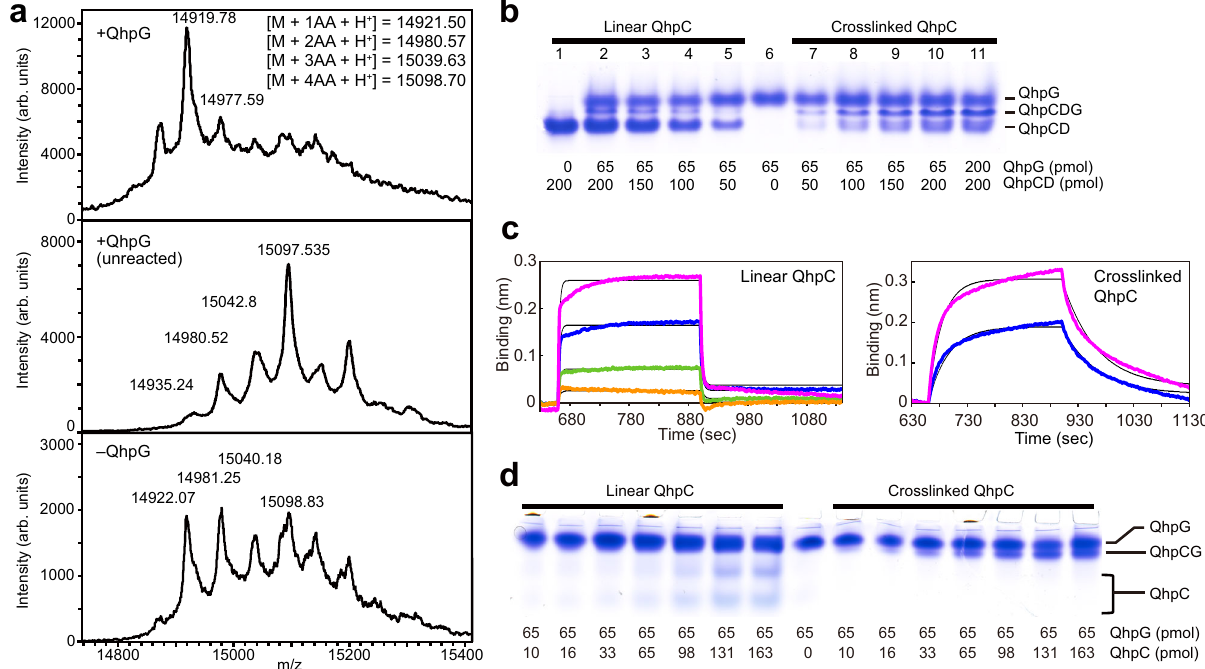
Fig. 2 Effect of QhpG on QhpD-catalyzed thioether bond formation in QhpC and inter-protein interactions among QhpCDG proteins. a MALDI-TOF mass spectra are shown for IAA-treated products (crosslinked QhpC) of the QhpD-catalyzed thioether bond formation in the presence of an equimolar amount of QhpG (top panel) and in its absence before (middle) and after (bottom) the QhpD reaction. Inset: Calculated m/z values of 1 – 4 acetamidated (AA) peptides (monoprotonated form). Intensity is expressed in arbitrary units (arb. units) for all mass spectra. Mobility shift assays for interactions between QhpG and the QhpCD binary complex ( b ) and between QhpG and QhpC ( d ). Indicated amounts (pmol) of respective proteins were applied in each lane. In b , d , the experiments repeated twice independently gave similar results. c BLI assays for interactions between QhpG and linear (left) and crosslinked (right) QhpC immobilized on the biosensor tip. The analyte solution (4 μ l) contained QhpG at 1.0 μ M (magenta), 0.50 μ M (blue), 0.25 μ M (green), and 0.13 μ M (orange) for linear QhpC (left) and at 62.5 nM (magenta) and 31.3 nM (blue) for crosslinked QhpC (right). Binding-induced changes in wavelength (nm) of the transmitted light were recorded for measuring time (s). Thin black curves represent the theoretical fi tting of the calculated data (Supplementary Table 1).